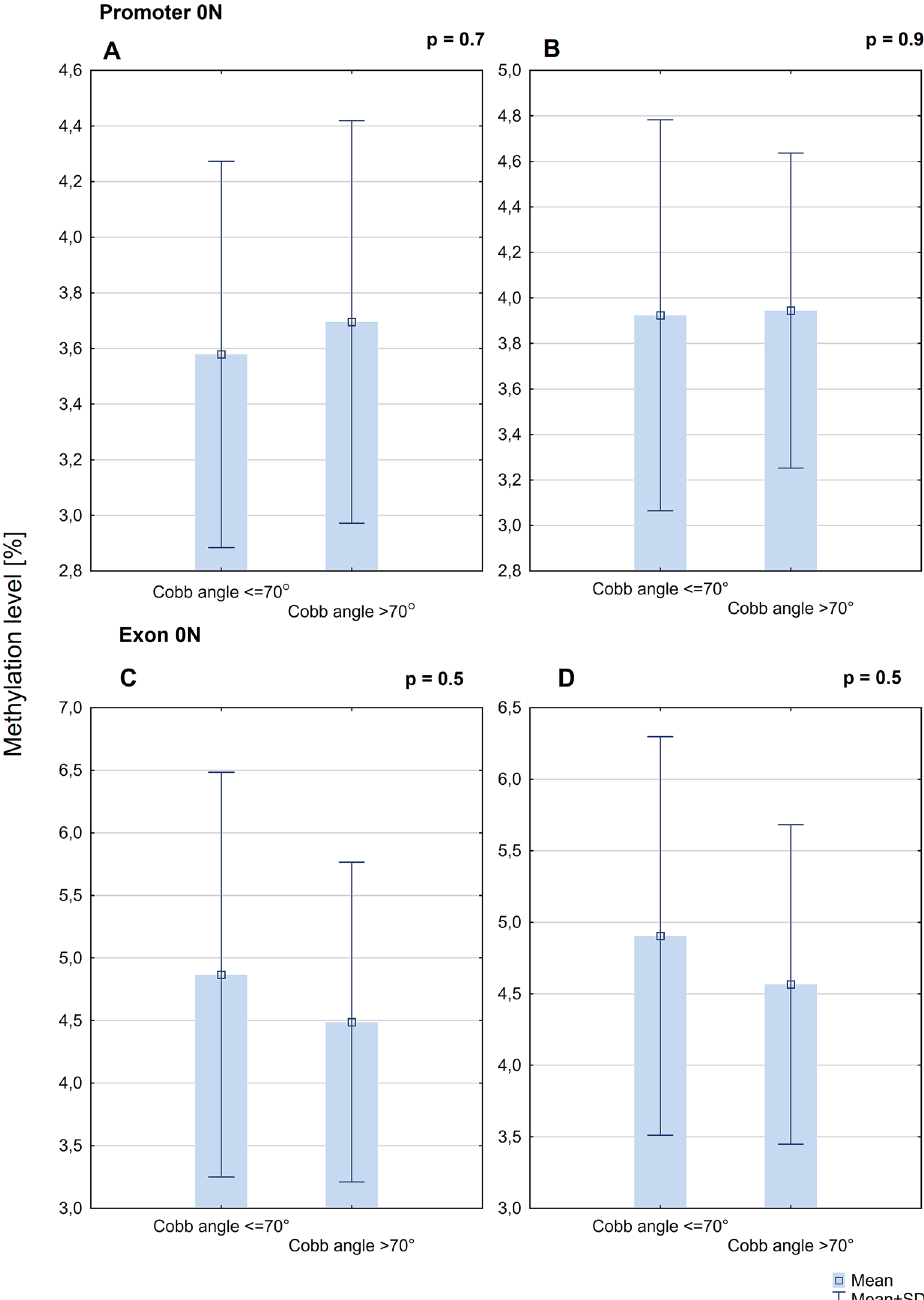
Figure 6. DNA methylation level within ESR2 promoter 0N on the convex ( A ) and concave side of the curvature ( B ) and exon 0N on the convex ( C ) and concave ( D ) side of the curvature in the group of patients with Cobb angle ≤ 70° and >